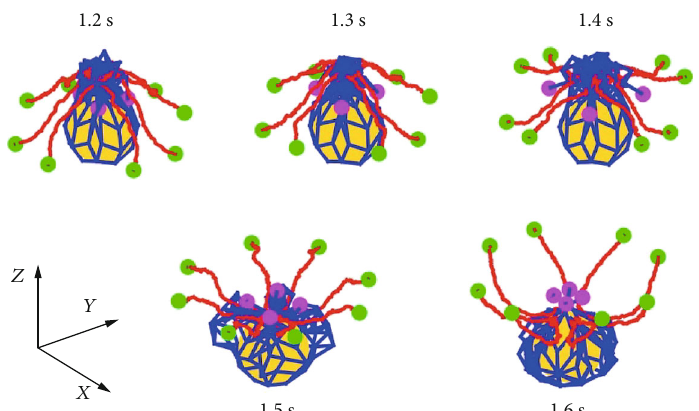
Figure 14: Five cases with di ff erent starting times of